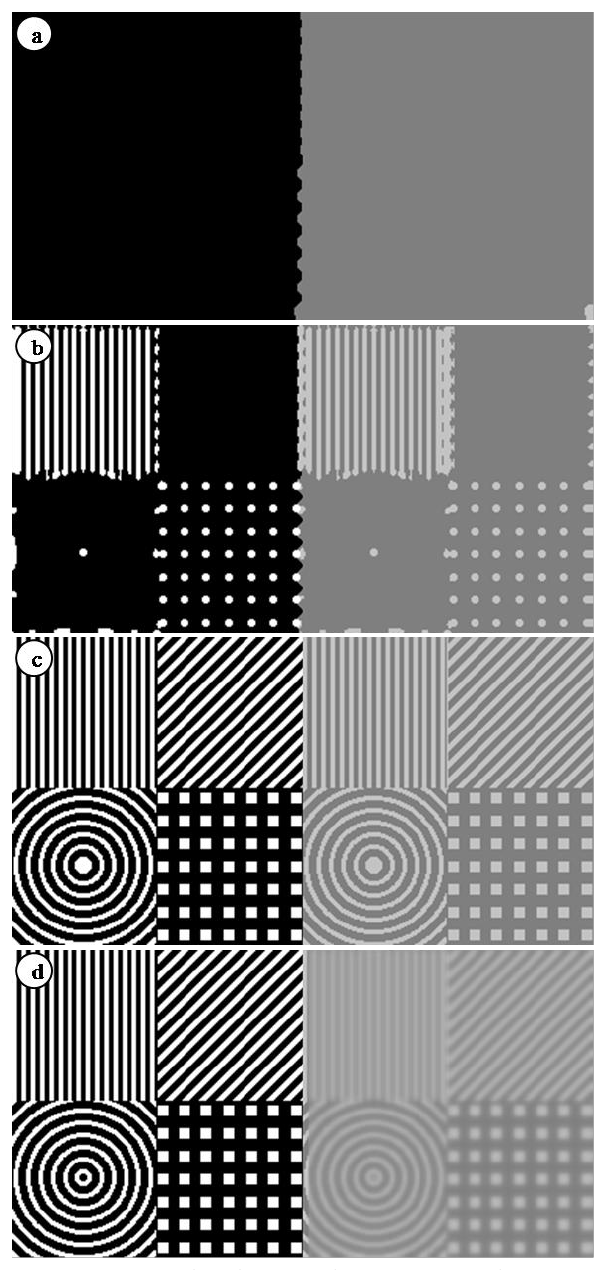
Figure 4. Results of the filtration of detailed speckle-free image using: a) SAF, b) Median filter, c) MSE filter by reconstruction,